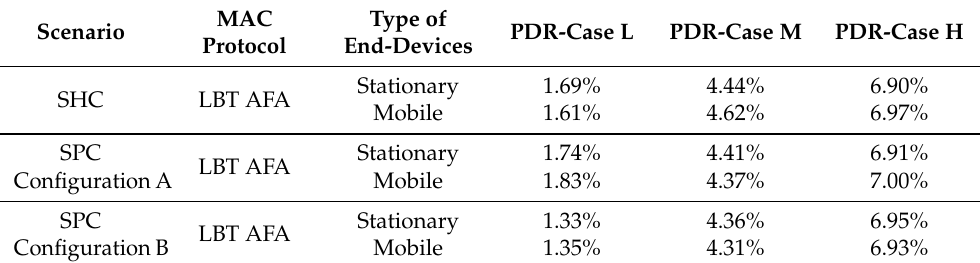
Table 9. Average PDR under different traffic conditions (LBT AFA